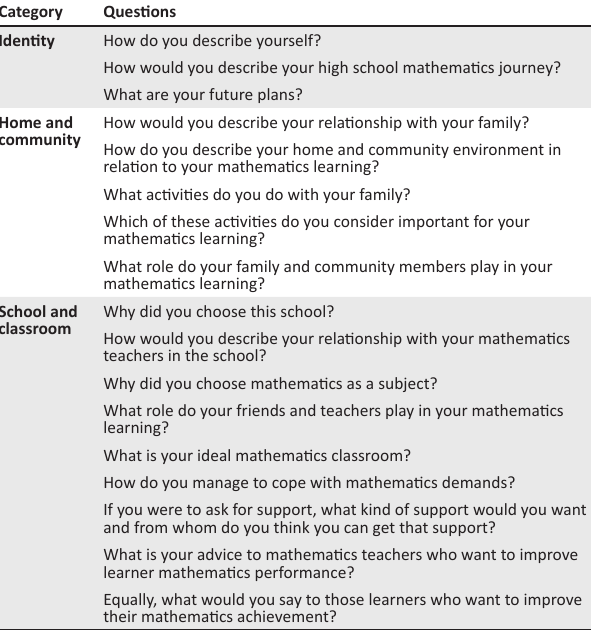
TABLE 1: Interview questions.